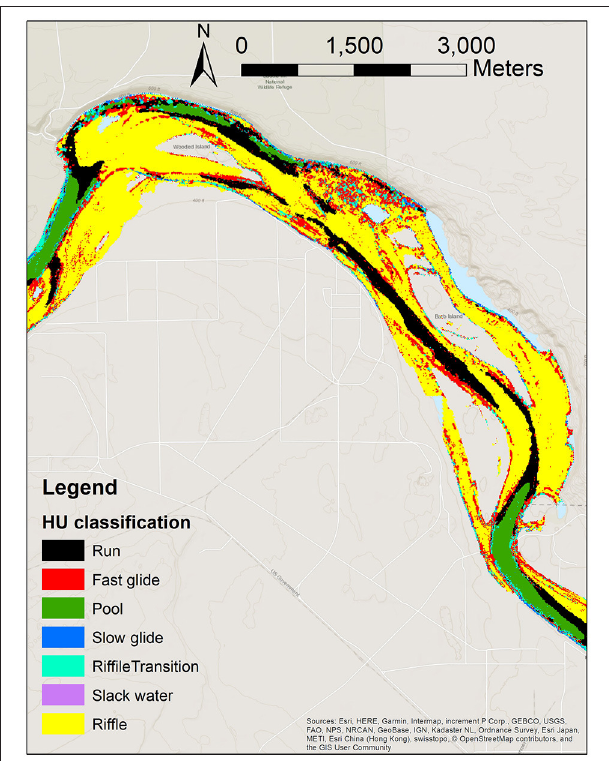
FIGURE 2 | Map of hydromorphic unit (HU) classes in the simulation